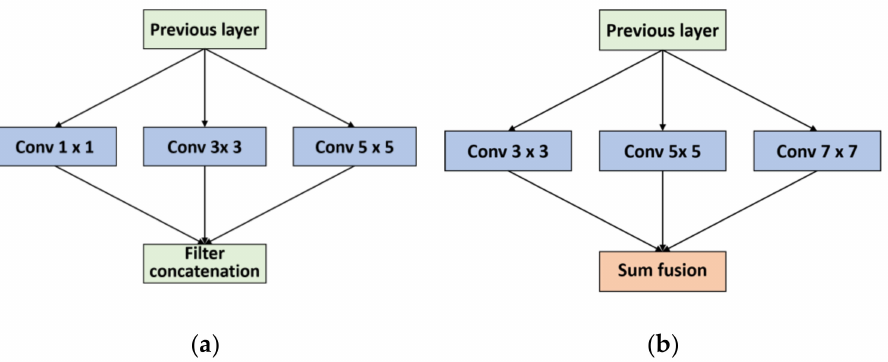
Figure 3. The multiscale convolutional kernel model. ( a ) The naïve inception module. ( b ) The proposed multiscale fusion